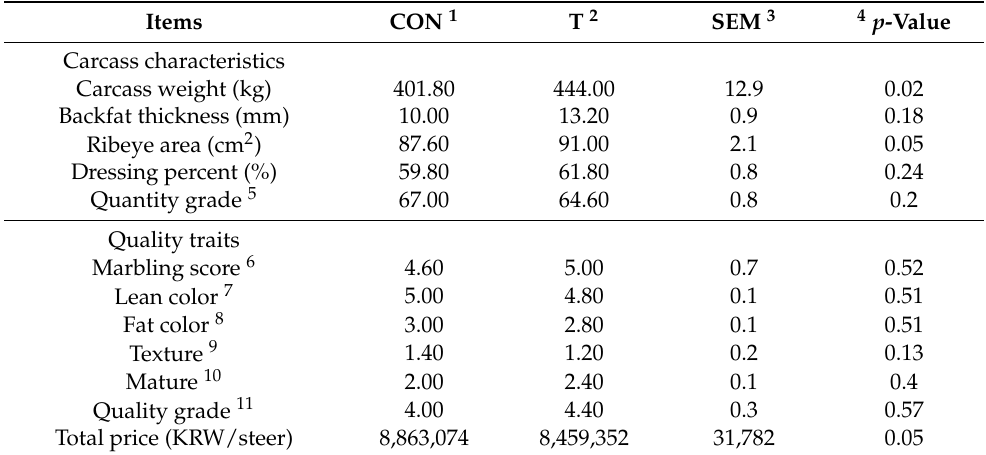
Table 4. Carcass characteristics and quality traits of Hanwoo steers fed control or formulated feed.